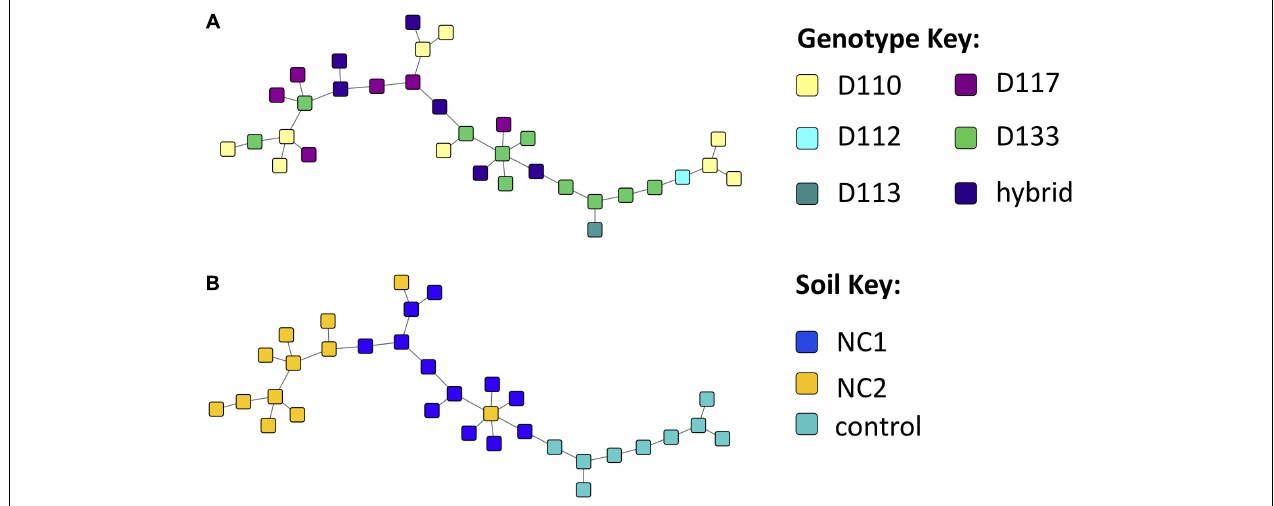
FIGURE 4 | Experiment 1 sample similarity Maximum Spanning Trees (MSTs), constructed using the Proportional Similarity metric, representing similarity of samples based on their Operational taxonomic unit (OTU) content, colored by (A) soil and (B) genotype.